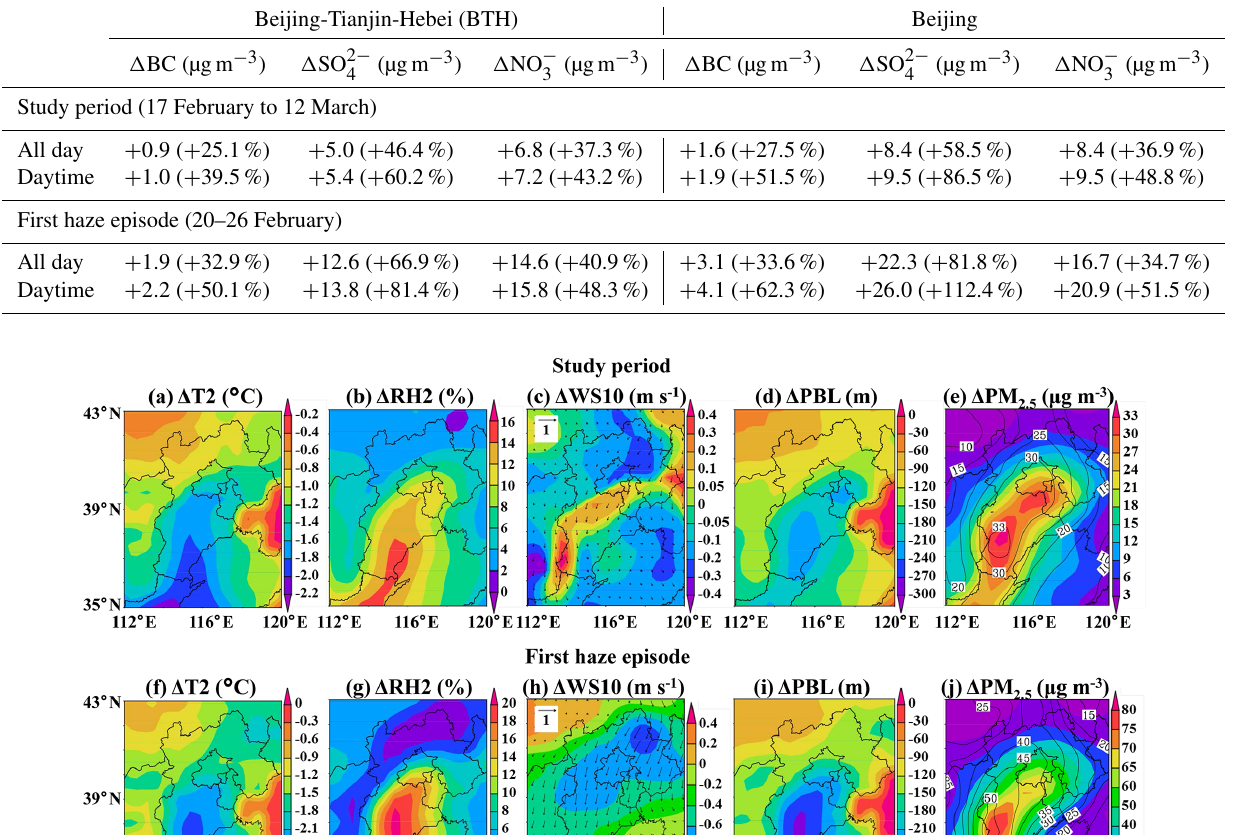
Table 7. The model-simulated feedback-induced changes (FULL minus NoAFB) in BC, sulfate (SO 2 − the BTH region and Beijing during the entire period and the first haze episode. Inside the parentheses are percentage changes relative to the NoAFB case.